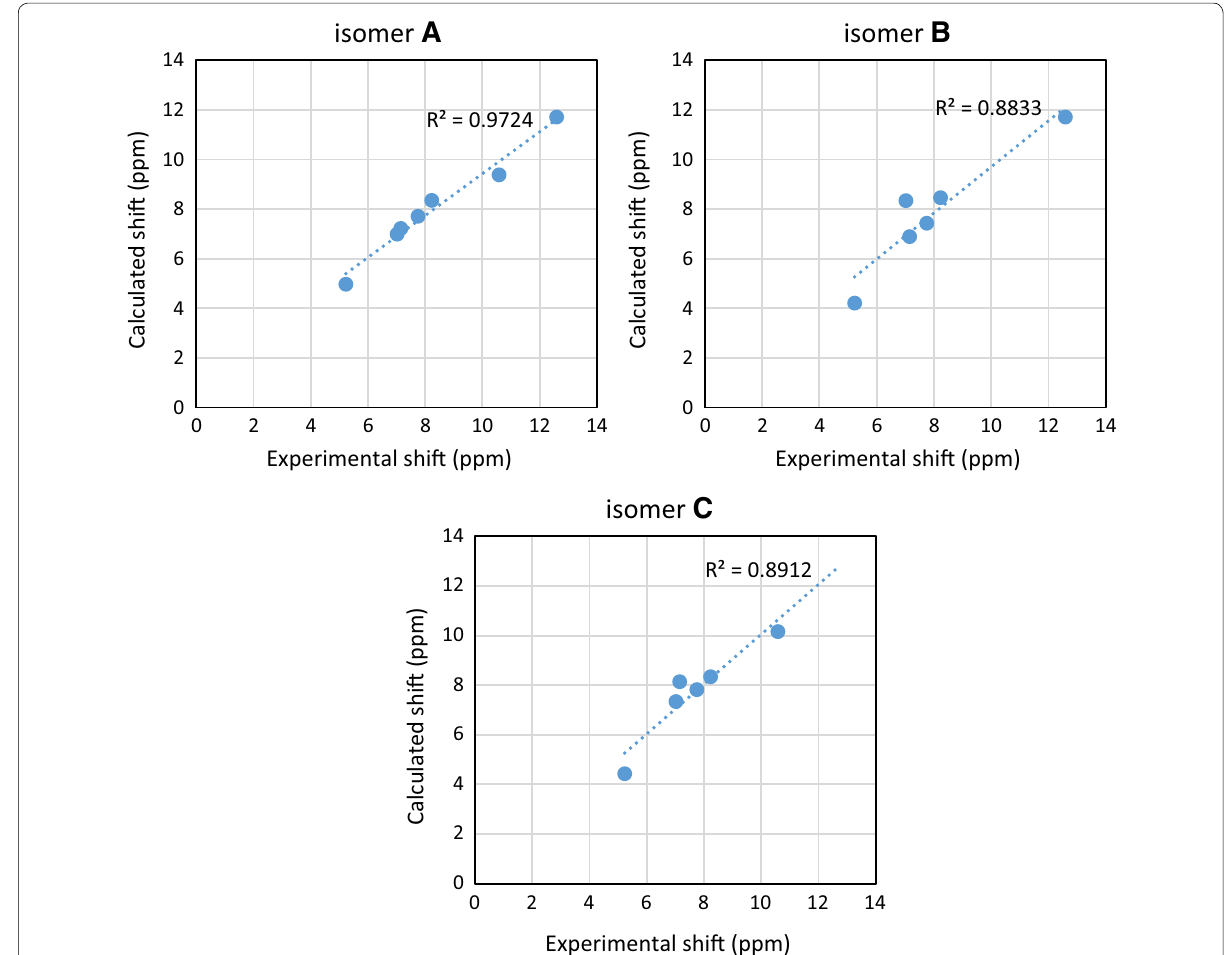
Fig. 4 The assignment of linear regression between experimental and calculated shift (ppm) of possible